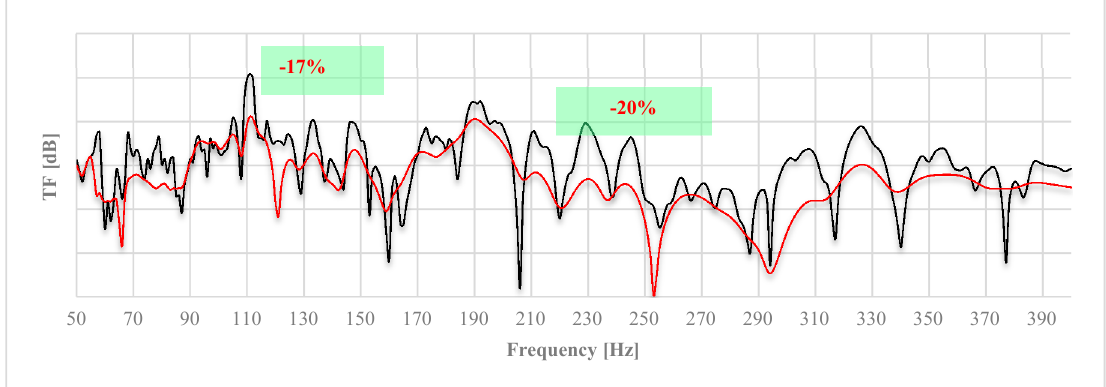
Figure 29. Vibroacoustic transfer functions (TF) from the shock absorber attachment to the ear node (MIC 2)—contribution from the pavilion only, considering the two materials: TCA (black line) and PP23CF OPTIMIZED (red line).